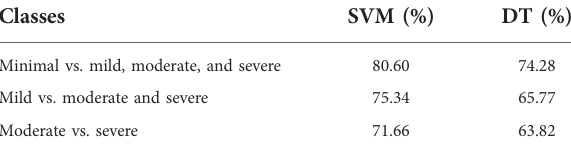
TABLE 5 Hierarchical classi fi cation according to class.